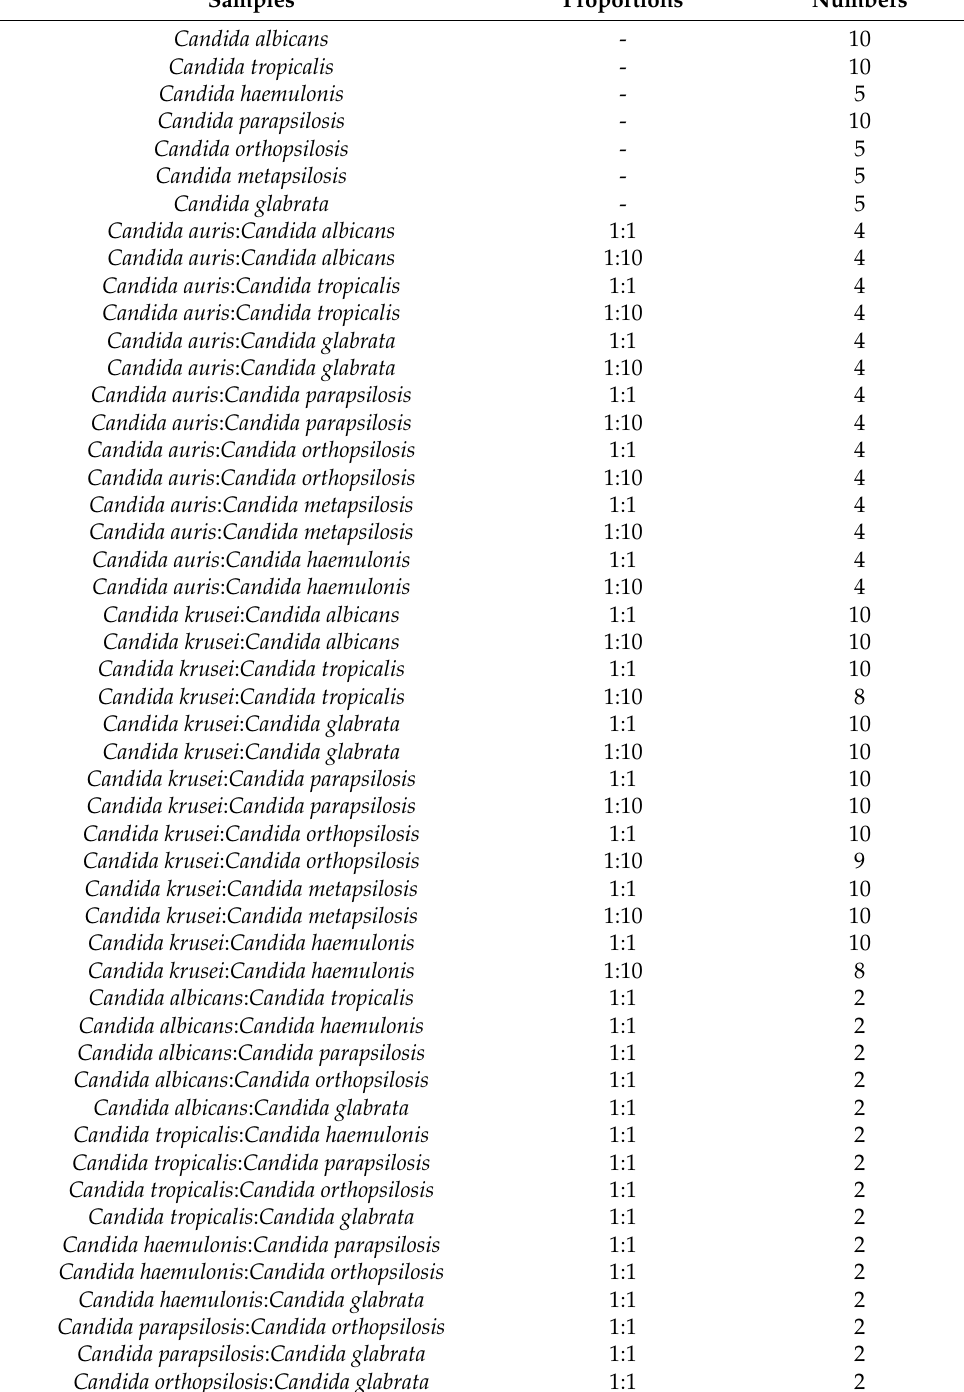
Table 1. Candida strains and simulated samples used in this